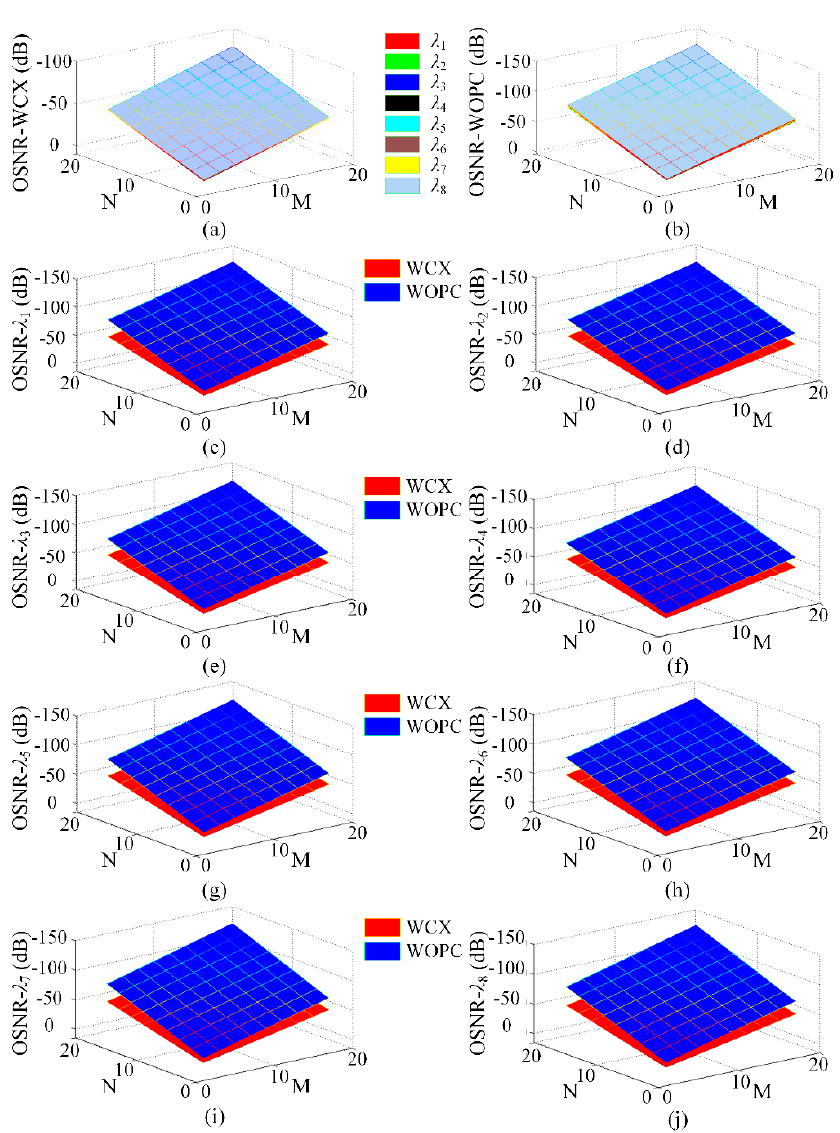
Figure 9. Optical signal-to-noise ratio (OSNR) comparison in M × N WDM-based torus ONoCs using the WOPC and WCX optical routers: ( a , b ) The OSNR at all wavelengths; ( c – j ) the OSNR at each wavelength.